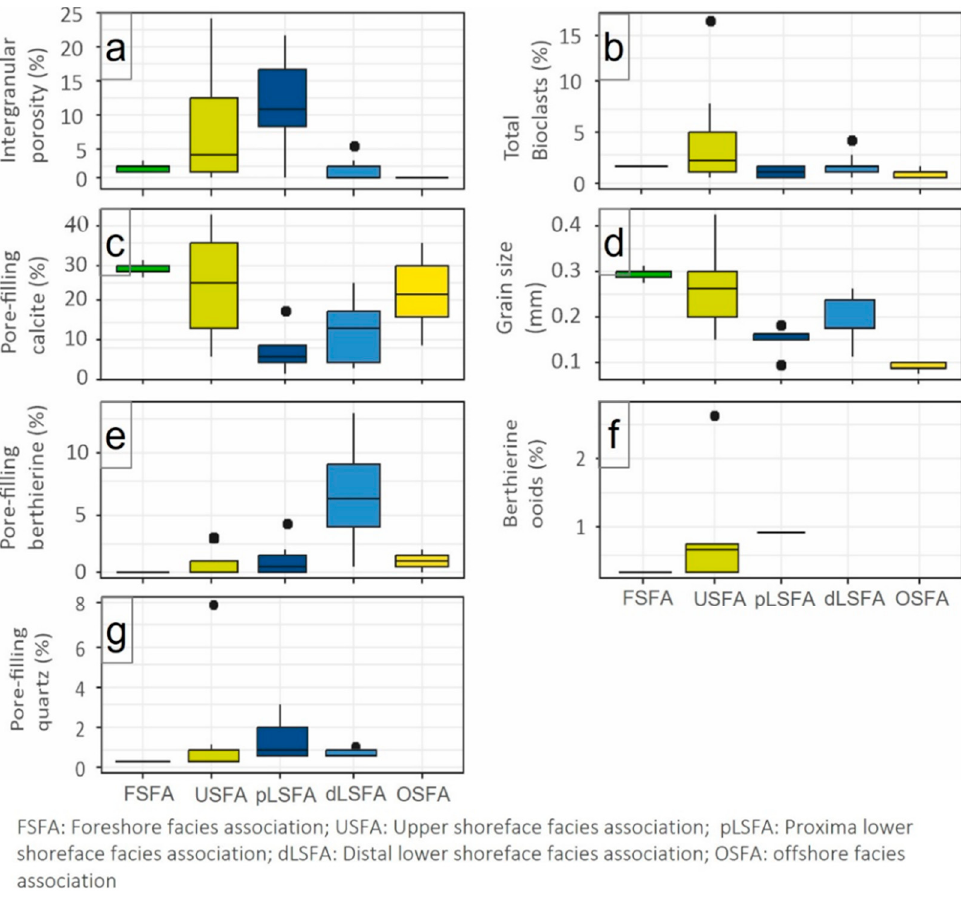
Figure 14. Boxplots relating point count data to facies associations: ( a ) intergranular porosity, ( b ) bioclasts, ( c ) pore-filling calcite, ( d ) grain size, ( e ) pore-filling berthierine, ( f ) Fe-ooids, and ( g ) pore-filling quartz. Intergranular porosity and pore-filling calcite show an inverse relationship while bioclasts and grain size show a good relationship with both reducing basinward from foreshore to offshore facies association. Pore-filling berthierine show an increasing trend from the foreshore to the proximal lower shoreface ( e ) similar to Fe-ooids ( f ) suggesting a genetic relationship. However, the absence of Fe-ooids in the distal lower shoreface and offshore facies association suggests other sources of authigenic berthierine apart from reprecipitation of Fe-ooids.